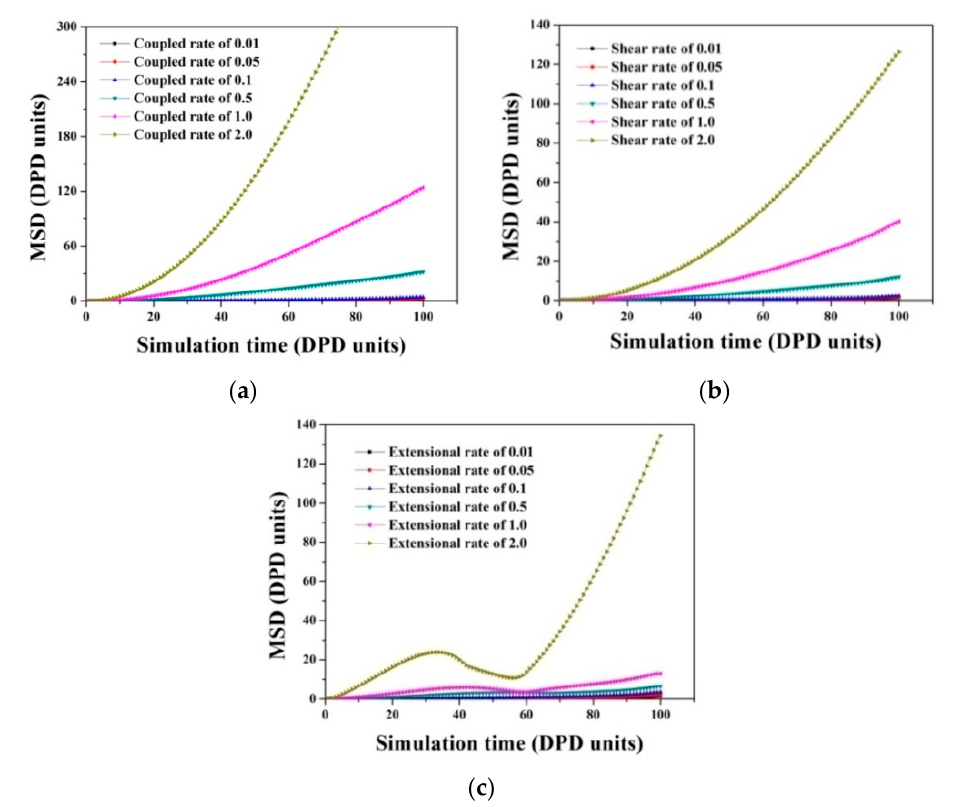
Figure 7. The mean square displacement (MSD) of PA6 at different simulation times corresponding to: ( a ) Extensional–shear coupled flow, ( b ) simple shear flow and ( c ) simple extensional flow at different rates.